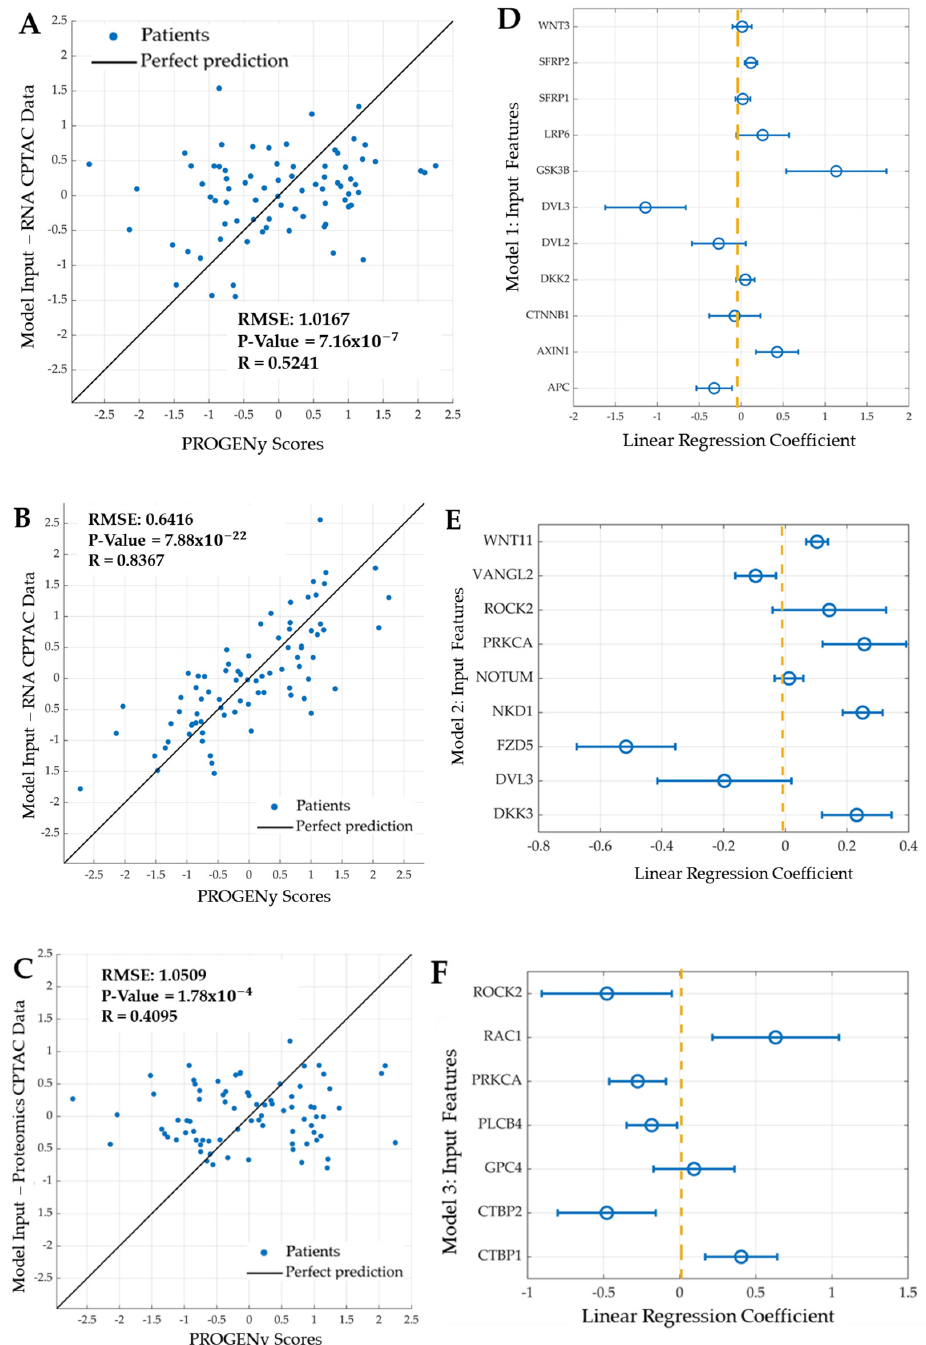
Figure 8. Linear regression machine learning models of the mechanistic and canonical WNT signalling pathways. Scatter plot visualising the correlation between the predicted score from ( A ) Model 1, using the 11 features of the mechanistic model ( y -axis), and the PROGENy scores ( x -axis). ( B ) Model 2, using the nine features of the canonical WNT model and significant genes ( y -axis), and the PROGENy scores ( x -axis). ( C ) Model 3, using the seven features of the canonical WNT model and significant proteins ( y -axis), and the PROGENy scores ( x -axis). Each blue dot represents 1 of 79 patients in the cohort. The black line indicates perfect predictions. “R” denotes the Pearson correlation coefficient, and “RMSE” is the root mean square error. The second row of figures represents the corresponding linear regression correlation coefficients for Models 1–3. Presented are the regression coefficients for the ( D ) Model 1, ( E ) Model 2, and ( F ) Model 3. The features used for each machine learning model are shown on the vertical axis, with the associated correlation coefficients shown on the horizontal axis. The blue dot represents the regression correlation coefficient, and the blue line (error bar) is the associated standard error. The dashed vertical yellow line represents the midline for the linear regression coefficients at